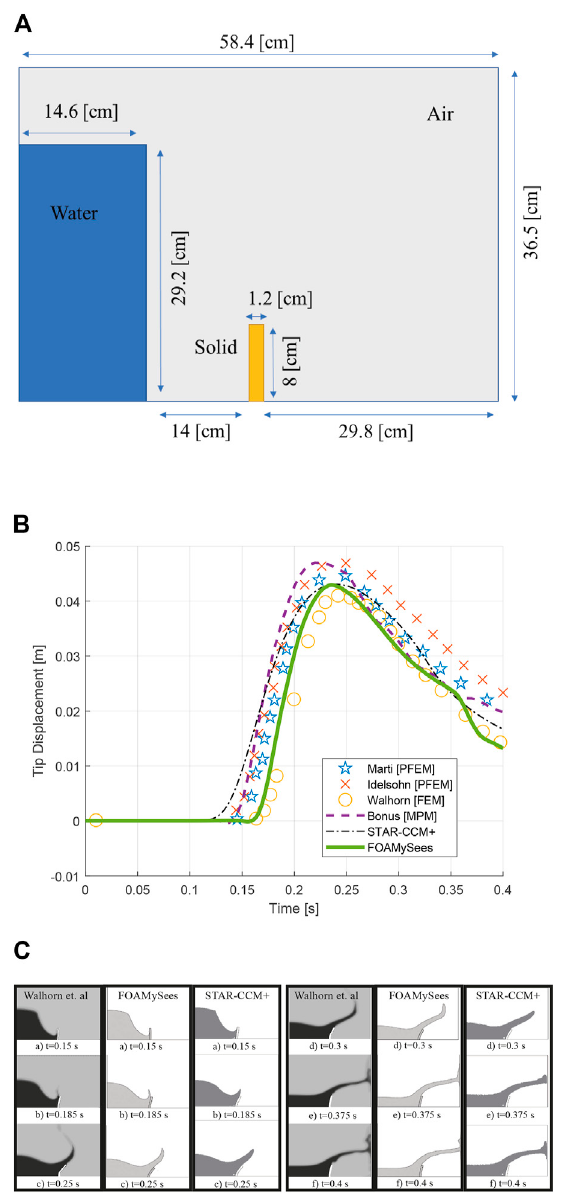
FIGURE 11 (A) Laminar multiphase hydrodynamic impact validation case setup, (B) Walhorn et al. Validation case: FOAMySees comparison to other solution, (C) Walhorn et al. fl uid free surface comparison: left, grey background-Walhorn et al. Center-FOAMySees. Right, white background-